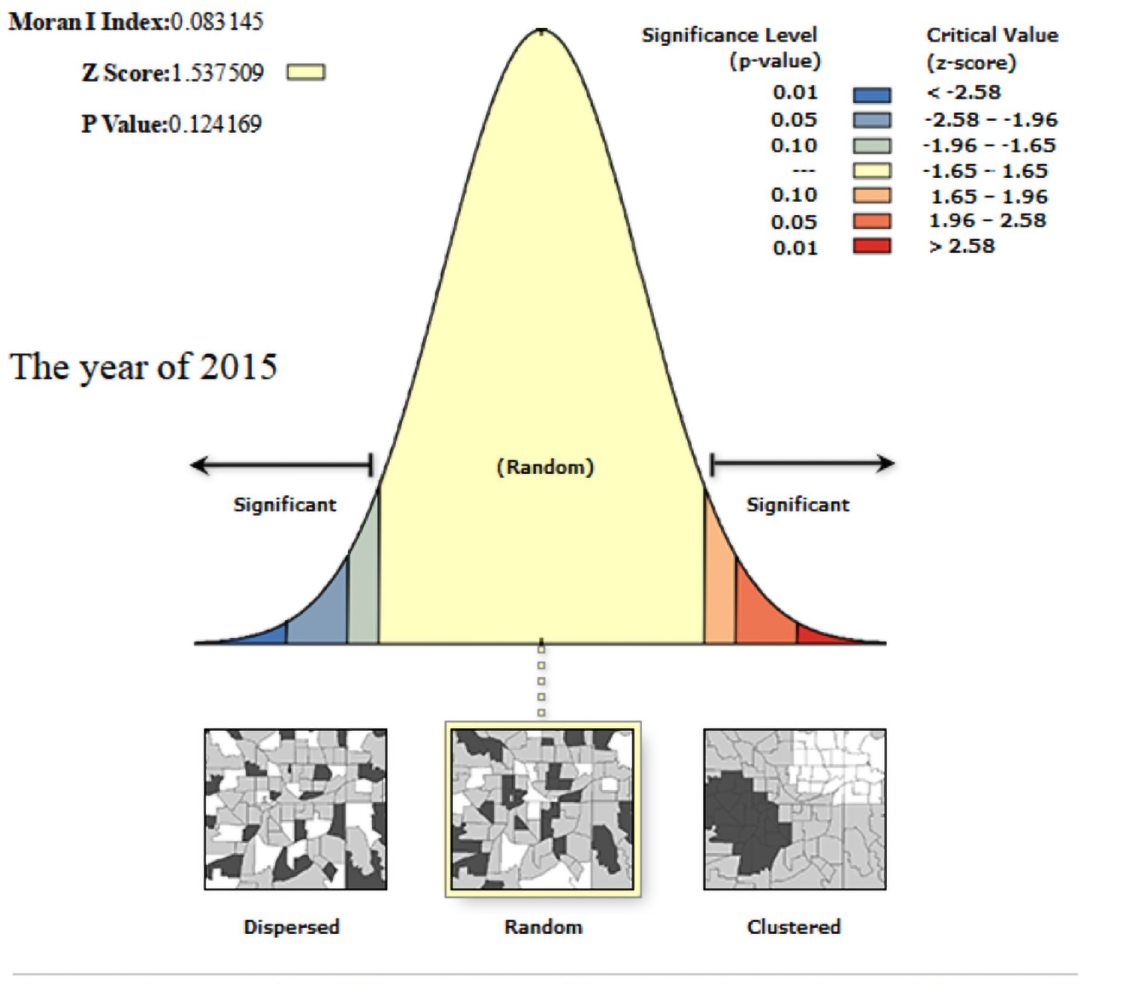
Fig 7. Spatial autocorrelation report of the coordination of the sports industry and health service industry of China in the year of 2015.